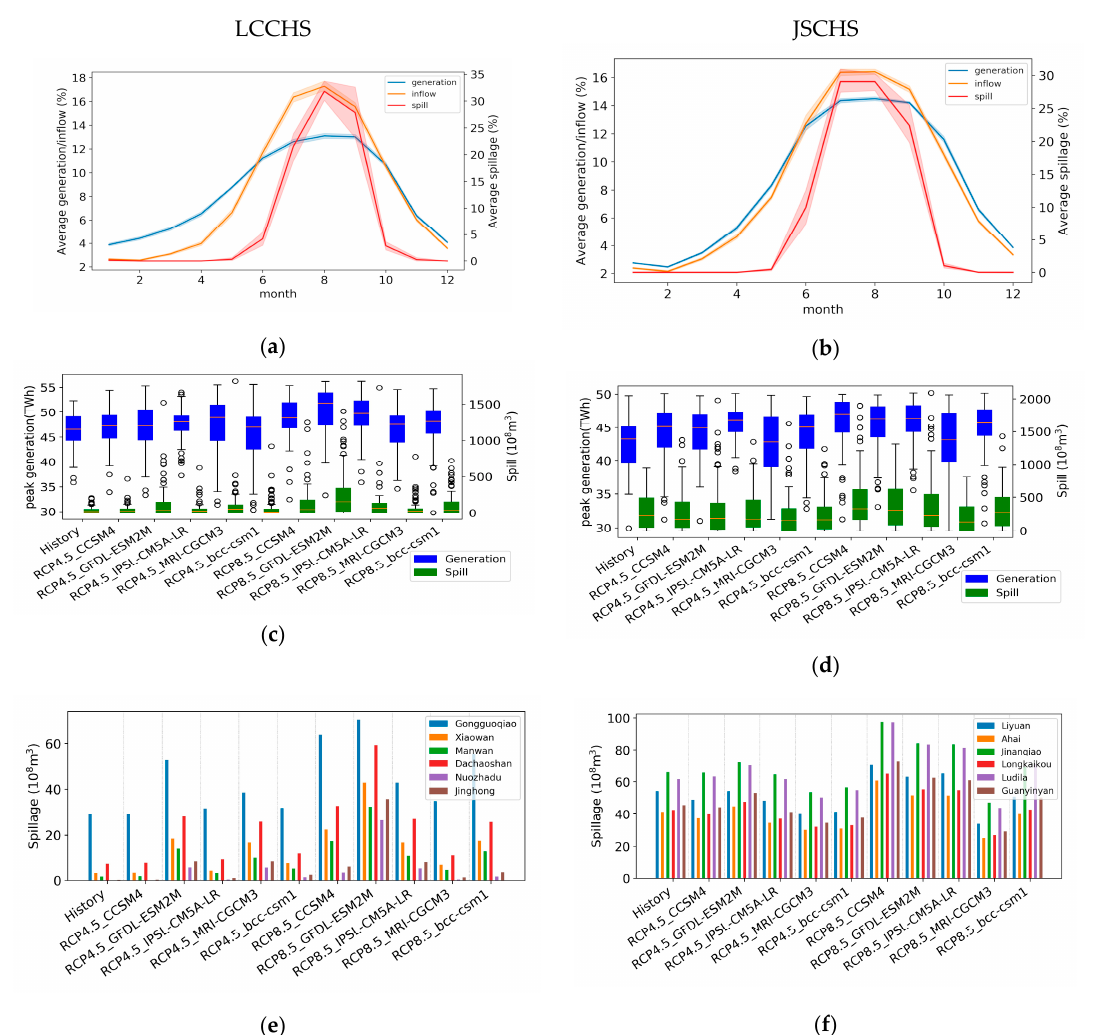
Figure 9. The spillage information of LCCHS and JSCHS. ( a , b ) Monthly average percentage of inflow, generation and spill; ( c , d ) peak generation and spill distribution; ( e , f ) yearly average spill at each station.